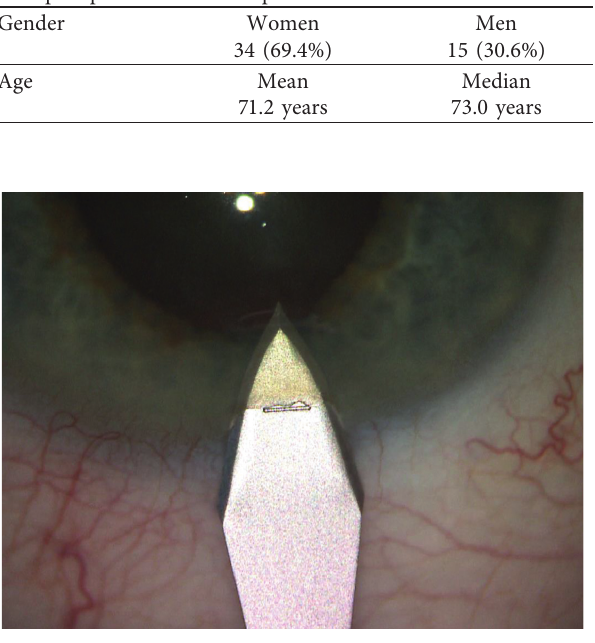
Figure 1: Bevel-up knife with a depth indicator with the reference line 2mm from the